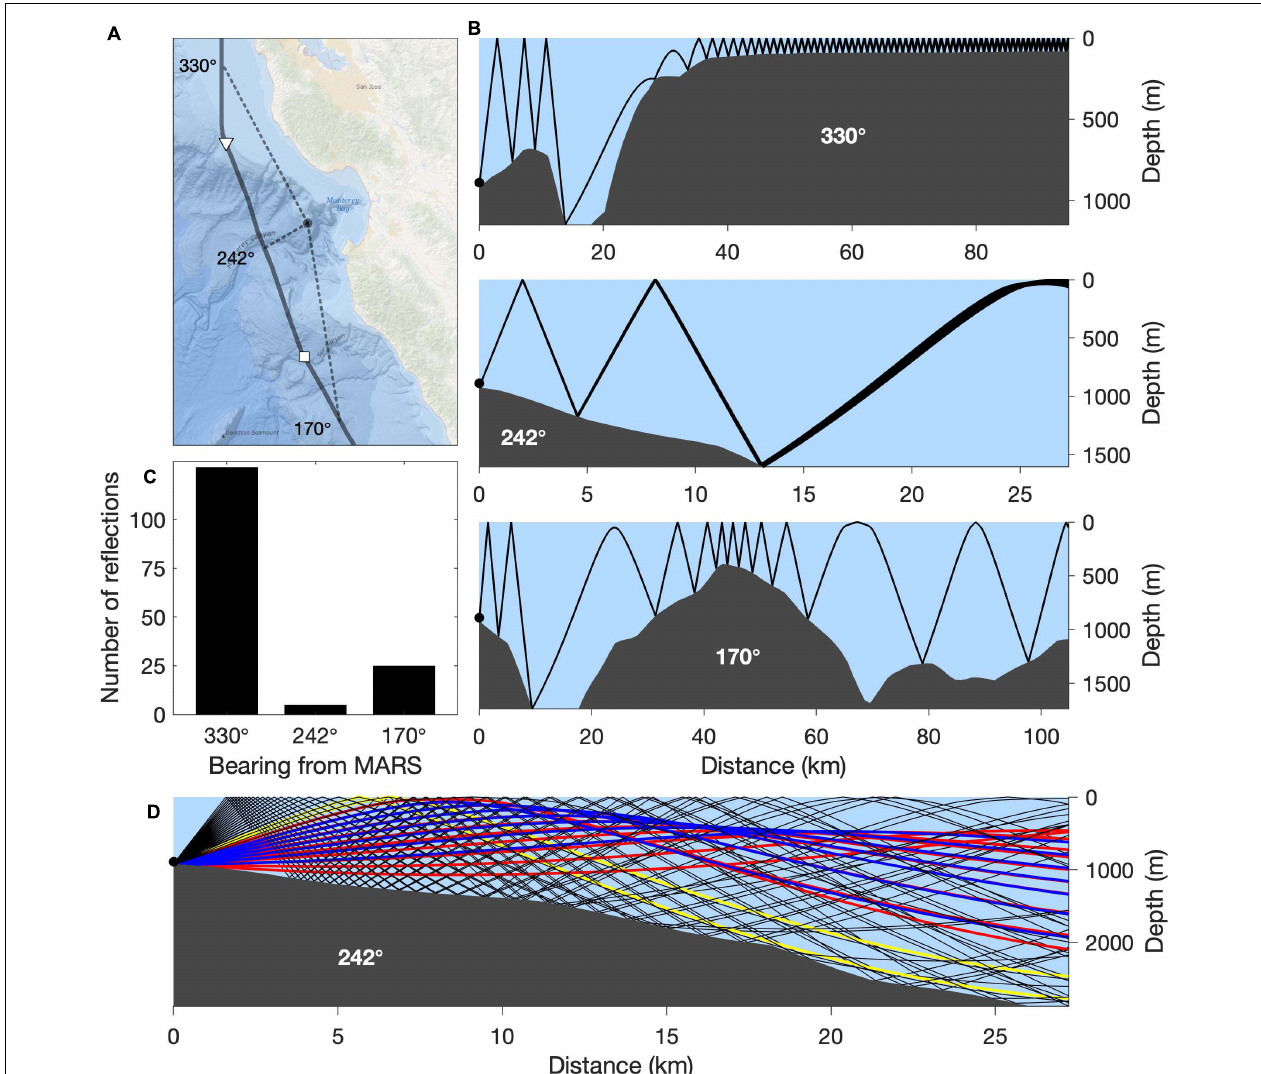
FIGURE 5 | Acoustical characterization of the recording site. (A) Map showing the track of the MSC SILVANA (as in Figure 4 ). (B) Eigenrays between vessel source and MARS receiver computed using the BELLHOP model for the bearings identified in (A) . (C) Total number of bottom and surface reflections for paths represented in (B) . (D) Ray trace results for the 242 ◦ bearing. Black lines represent ray paths with multiple boundary interactions (high loss). Yellow lines represent paths that have only one surface reflection (small loss, particularly on calm days). Blue lines represent paths with only one bottom bounce, very near the receiver. Red lines represent paths with no boundary interaction over the range shown. The blue and red paths are in the SOFAR